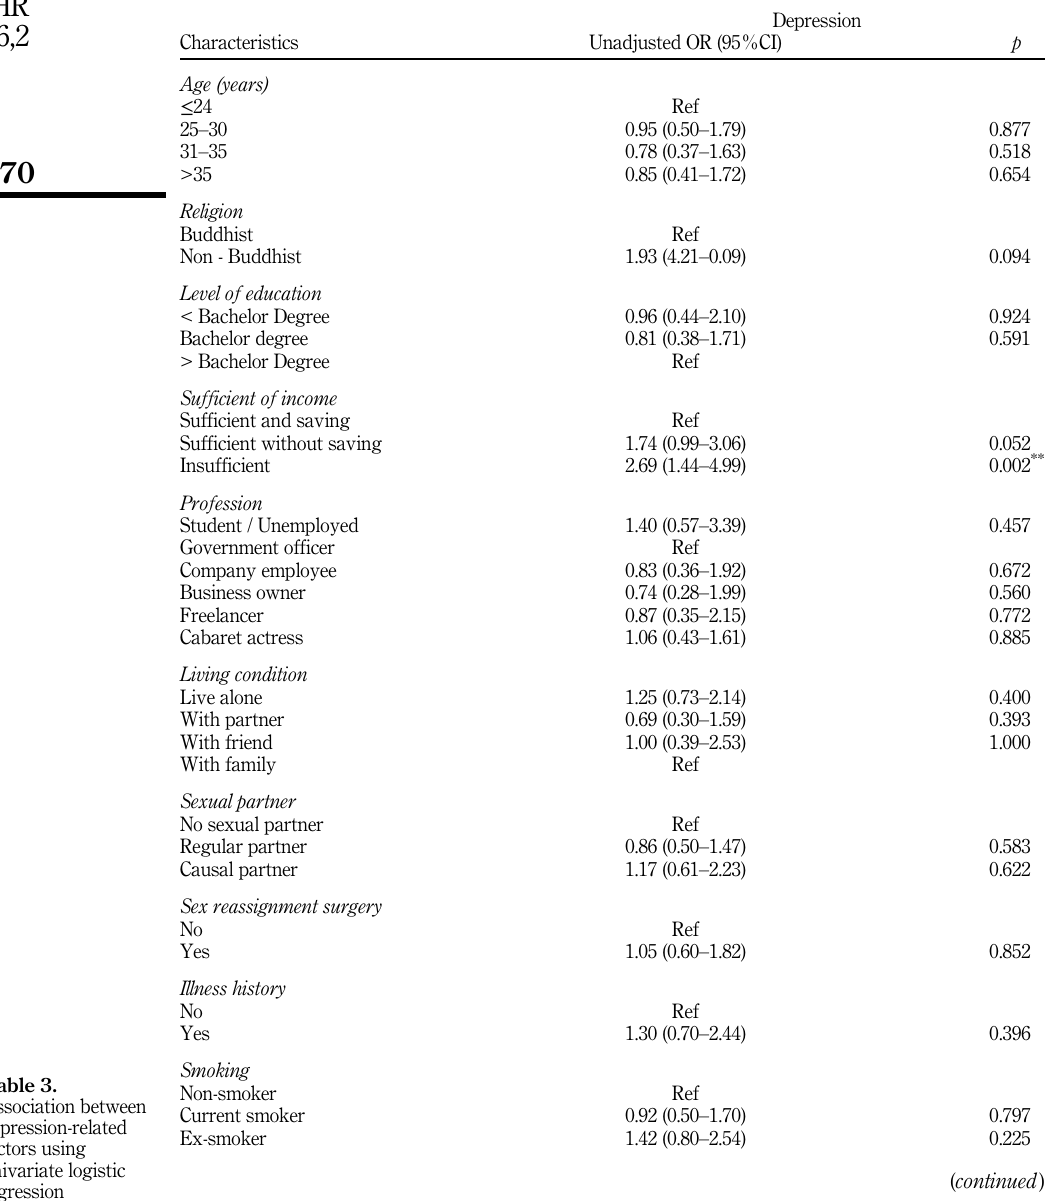
Table 3. Association between depression-related factors using univariate logistic